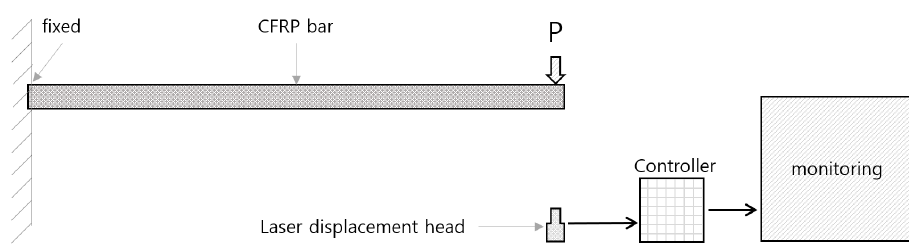
Figure 4. Cantilever test of a CFRP bar.